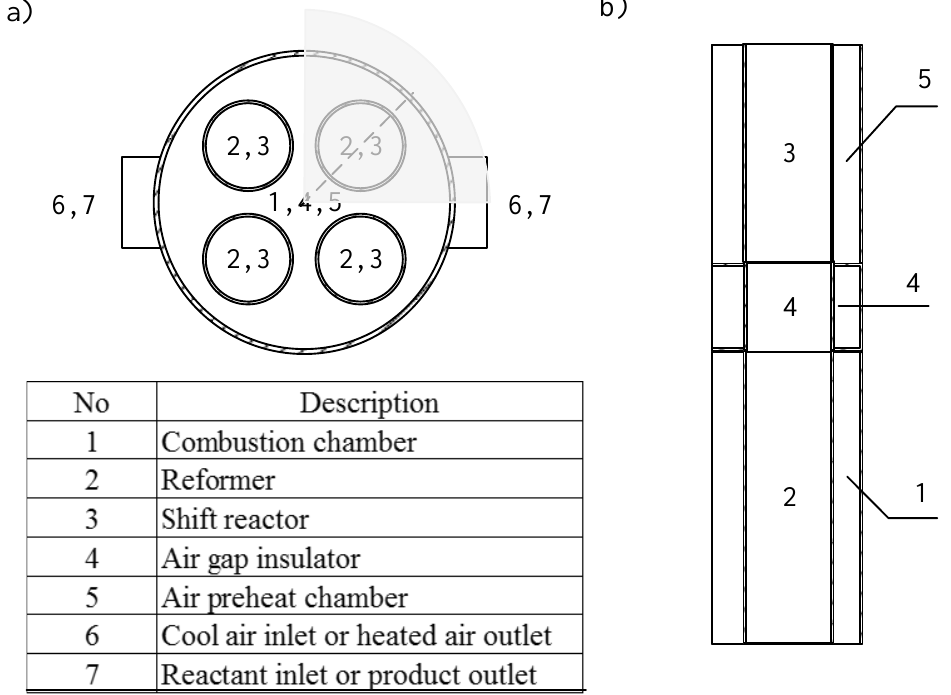
Figure 3. Configuration of CHIRS (II), shown in ( a ) top view and ( b ) cross sectional view (dotted line).